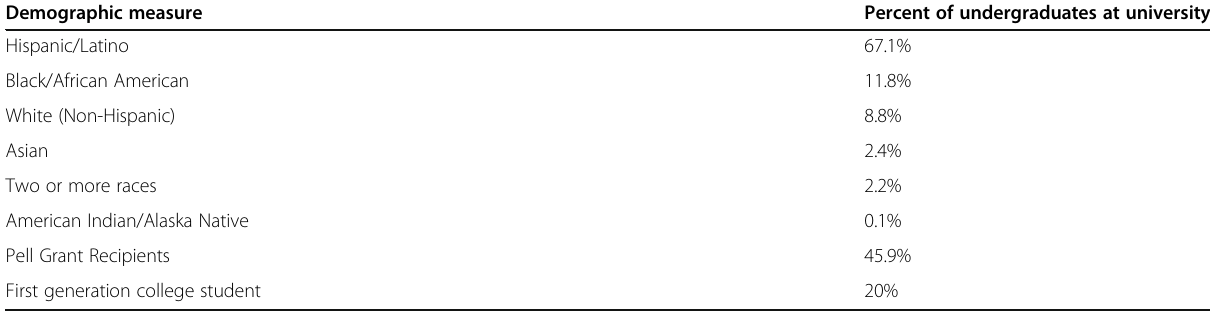
Table 3 Demographics of undergraduate population at the